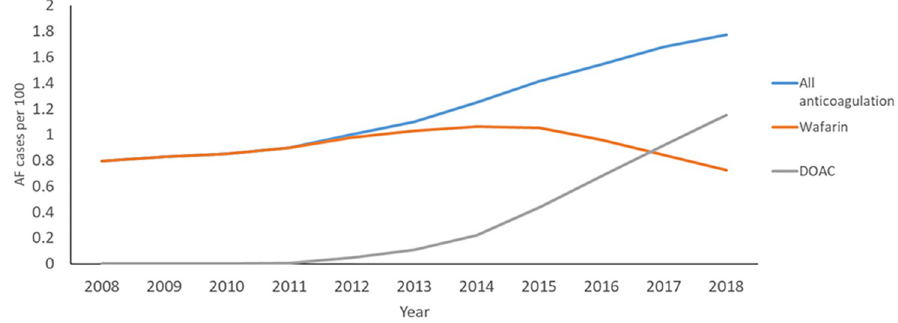
Fig 5. Change in use of Warfarin and DOACs over time, financial incentives to encourage increased detection in the management of AF introduced in 2014.